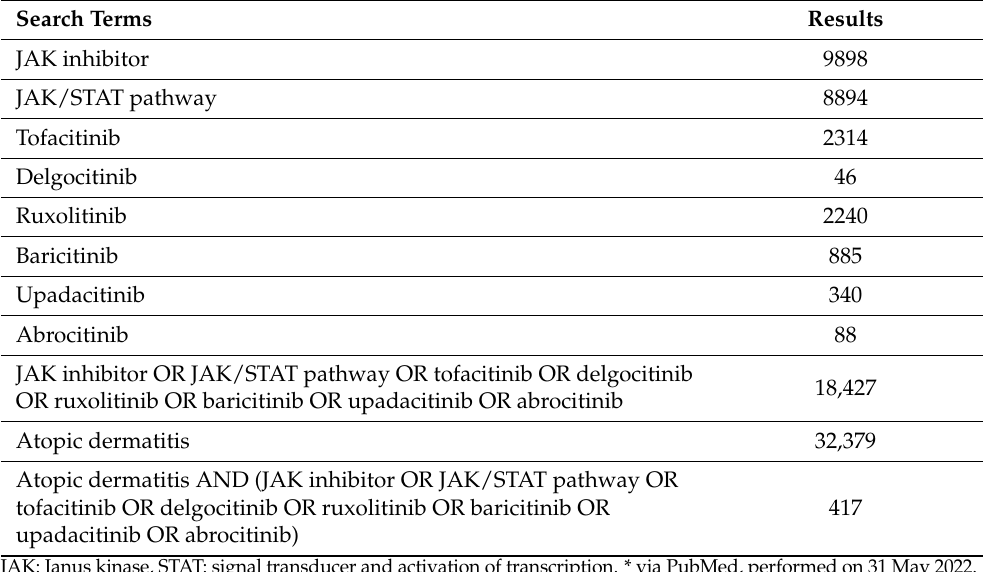
Table 1. MEDLINE search strategy